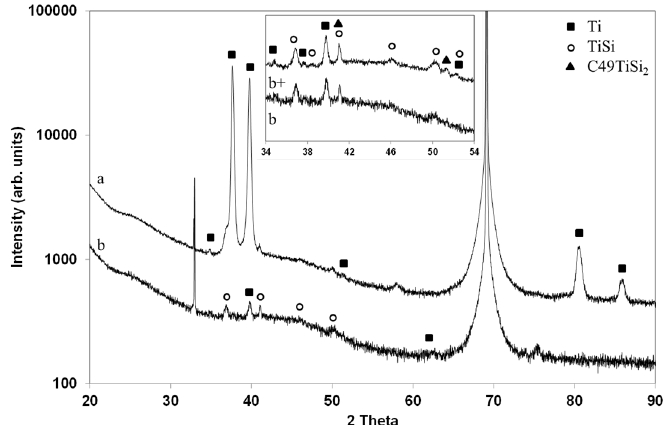
Figure 4. X-ray diffraction patterns of Ti films, 500 nm thick, heated at 500 ◦ C and processed in Figure 4. X ‐ ray diffraction patterns of Ti films, 500 nm thick, heated at 500 °C and processed in (Ar ‐ (Ar-33%N 2 -1%H 2 ) plasma for 1.5 h ( a ) and 3 h ( b 33%N 2 ‐ 1%H 2 ) plasma for 1.5 h ( a ) and 3 h ( b ).